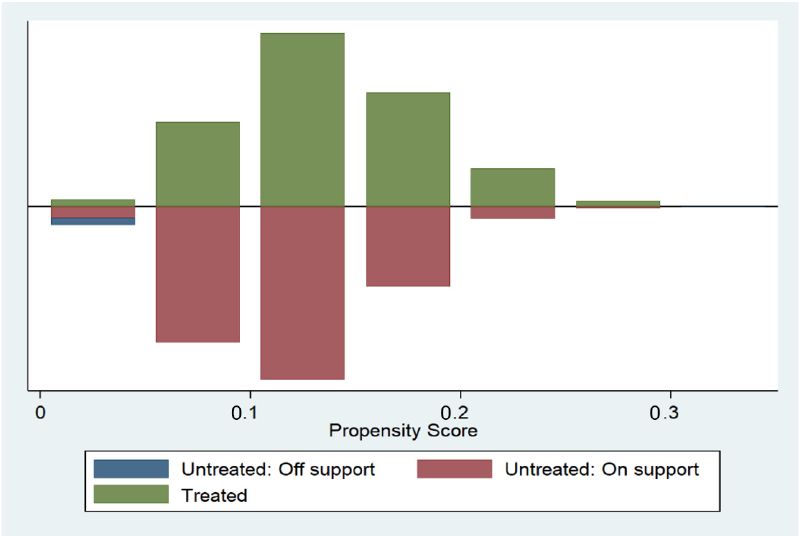
Figure 4. Propensity score between participants and non-participants in rental market